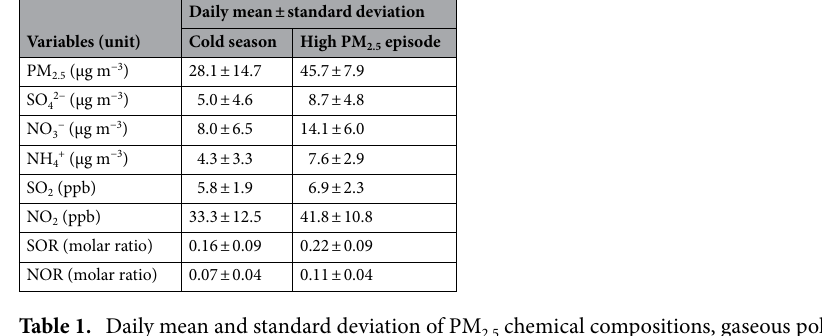
Table 1. Daily mean and standard deviation of PM 2.5 chemical compositions, gaseous pollutants, and oxidation ratios in Seoul for the cold season (November through March) and high PM 2.5 concentration episodes during